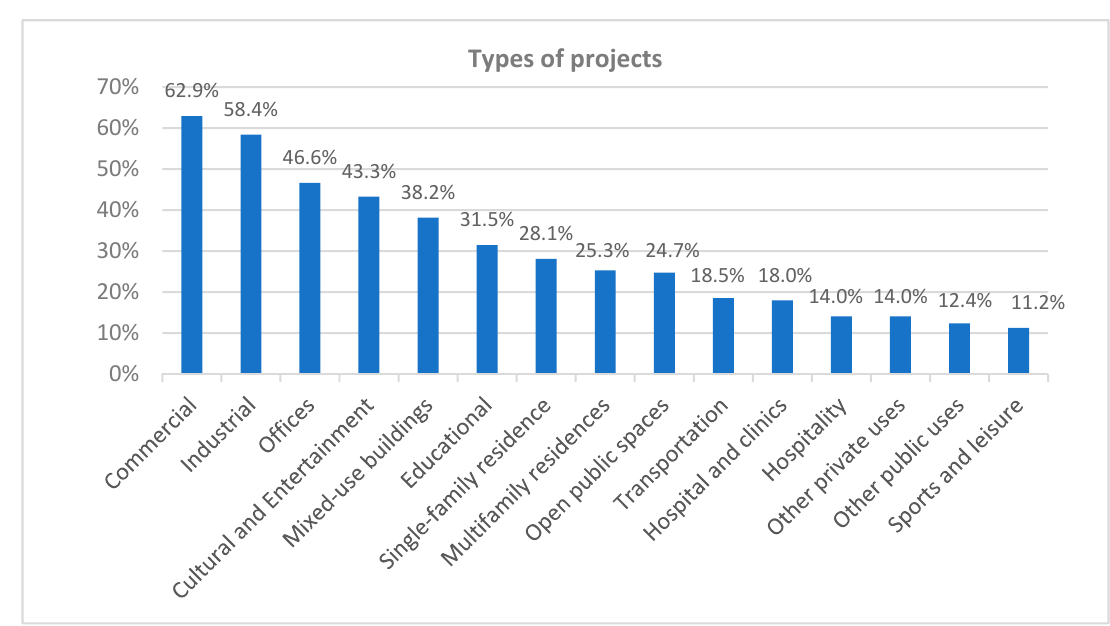
Figure 9. Types of scan-to-BIM projects worked in the last 12 months.